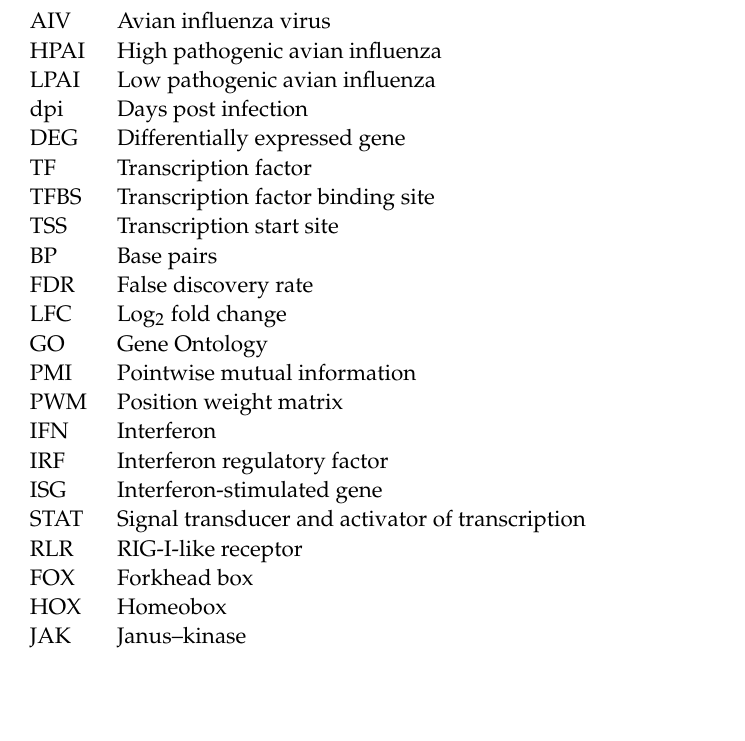
garding GO:Biological Processes of chicken and duck, Figure S2: Treemaps of the DEG sets regarding GO:Molecular Functions of chicken and duck, Figure S3: Full-size image of Figure 4, Figure S4: Schemes of the upstream regulatory networks revealing the top five master regulators of chicken and duck based on the TF-TF cooperation results, Figure S5: Schemes of the upstream regulatory networks revealing the top five master regulators of chicken and duck based on the TF enrichment results, Table S1: DEG sets for all experimental conditions, Table S2: GO-term enrichment of all DEG sets of chicken and duck, Table S3: enriched TFBSs in different promoter sets of chicken and duck, Table S4: TF cooperation networks of chicken and duck, File S1: PWMs included in the custom avian PWM profile, File S2: Cytoskape session of TF cooperation networks as .cys